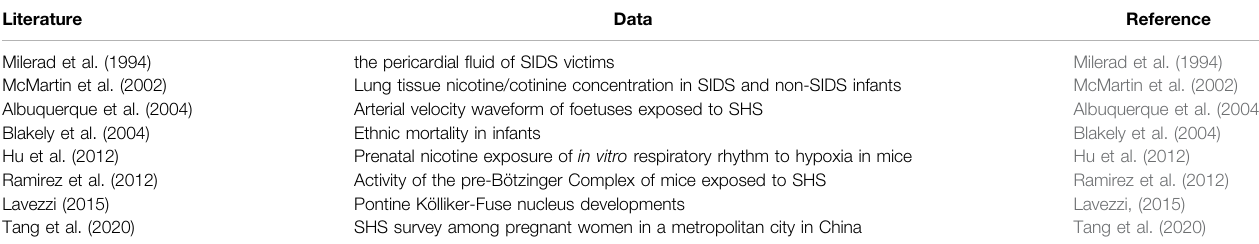
TABLE 1 | Clinical, experimental or epidemiologic data associated with SHS and SIDS mentioned in the paper. Literature